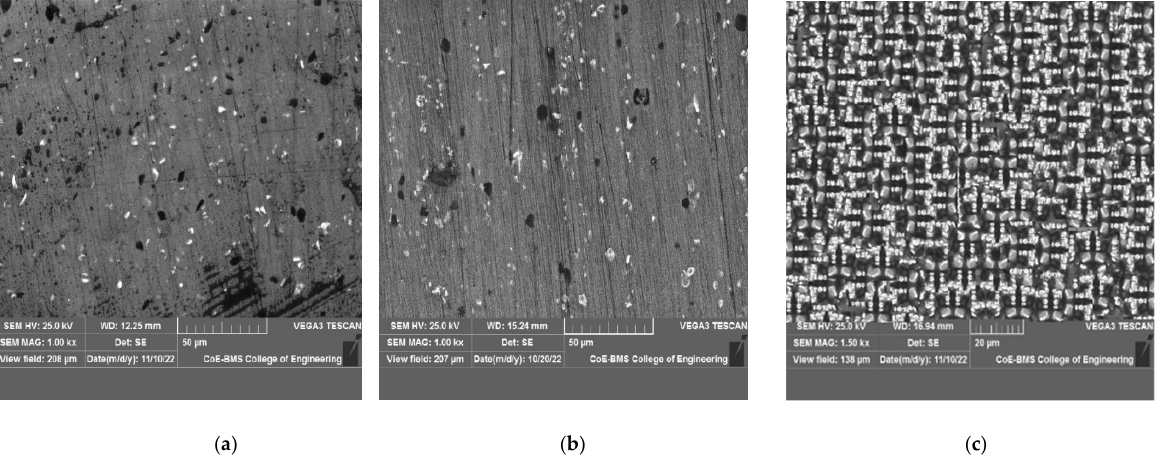
Figure 6. SEM images of a FSPed AA7075/ B 4 C sample prepared at ( a ) 800 rpm and 35 mm/min, ( b ) 41,000 rpm and 45 mm/min, and ( c ) 1400 rpm and 35 mm/min.